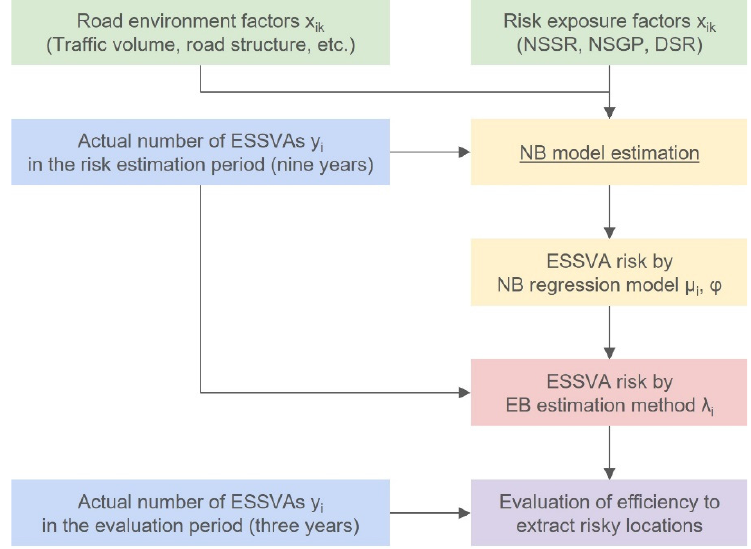
Figure 2. The flow of this study.